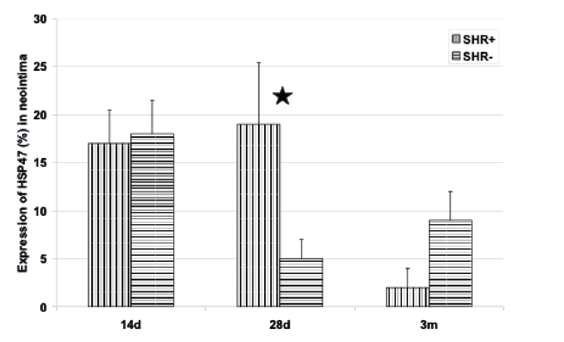
Figure 6C. Bar graph demonstrating expression of HSP47 in neointima with time after balloon angioplasty in spon- taneously hypertensive rats with (SHR+) and without ACE inhibitor (SHR-). Asterisk=